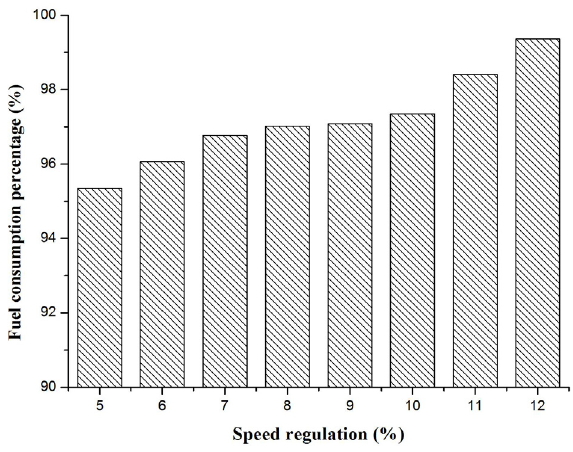
Figure 14. Fuel consumption percentage in the complex driving